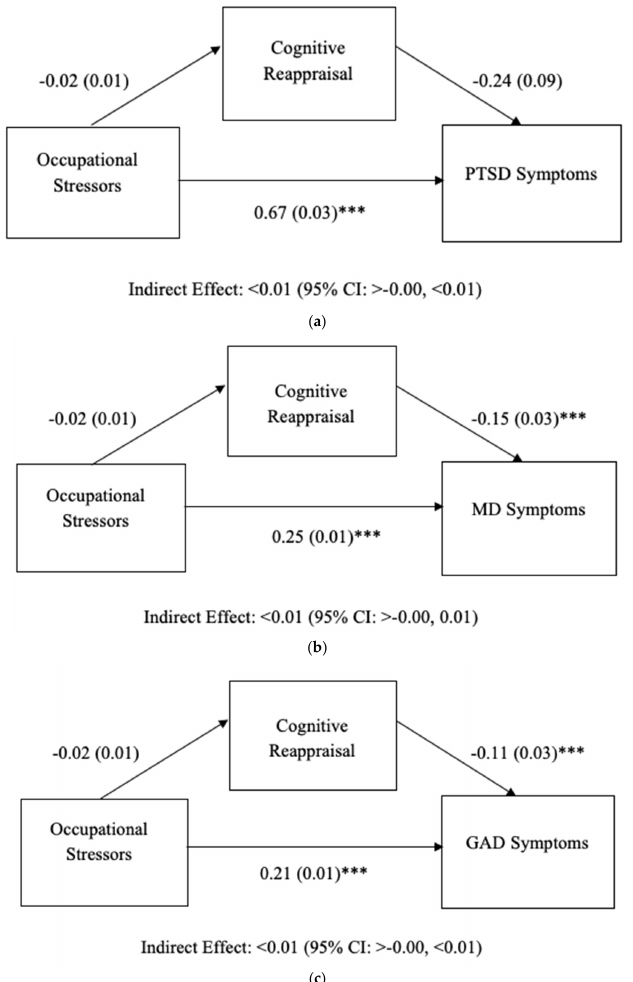
Figure 2. ( a ) Results of mediation model predicting PTSD. Analysis controlled for demographic (age, gender) and work-related (first response type, department, area, employment status, agency) variables. Occupational Stressors, Cognitive Reappraisal, PTSD: Posttraumatic Stress Disorder. ( b ) Results of mediation model predicting MD. Analysis controlled for demographic (age, gender) and work-related (first response type, department, area, employment status, agency) variables.